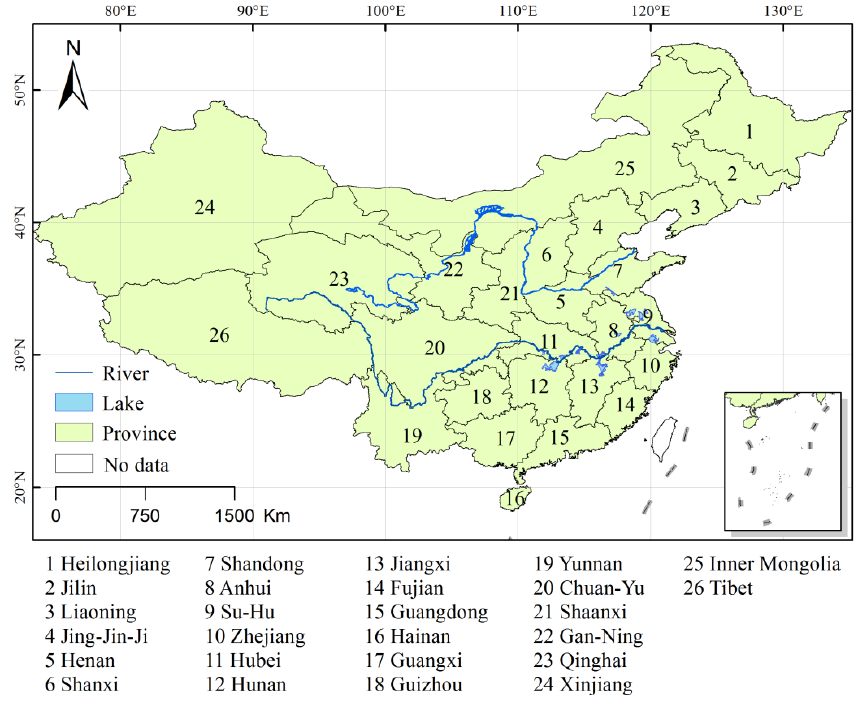
Figure 2. The geographical scope of the research